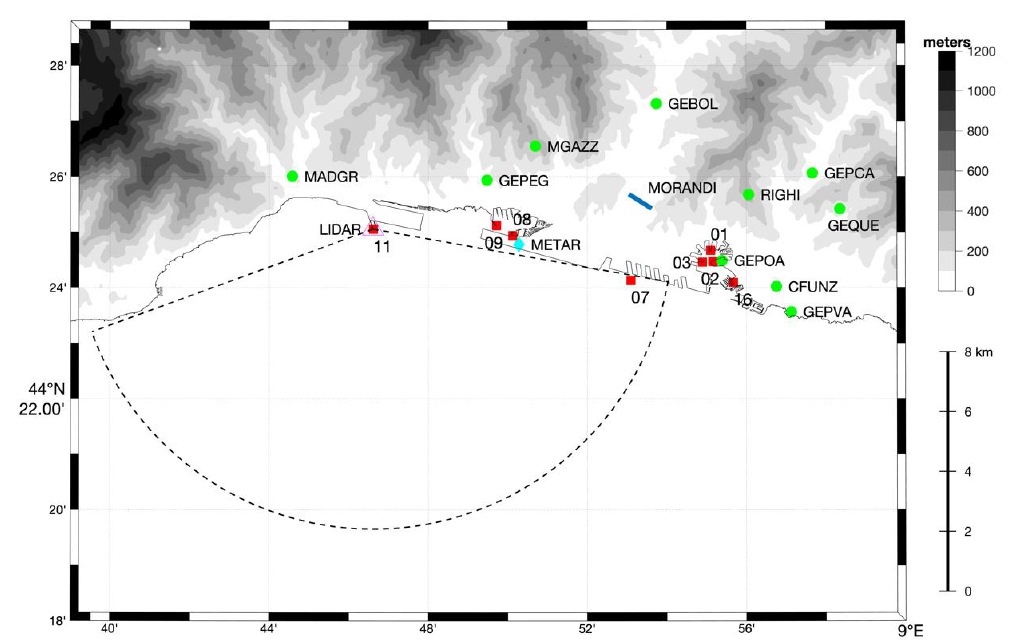
Figure 1. Topographic map of the Genoa region showing the position of Morandi Bridge (blue line), Regional Agency for Environmental Protection (ARPAL) meteorological stations (green circles), Port Authority anemometric stations (red squares), airport METAR station (cyan diamond), and lidar scanner of the University of Genoa (magenta triangle).